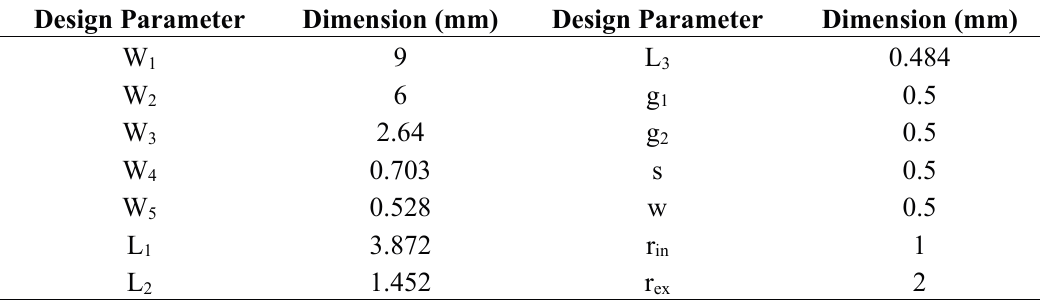
Figure 1. Front view of the complementary SRR unit cell with CLS. Table 1. Design parameters of the metamaterial unit